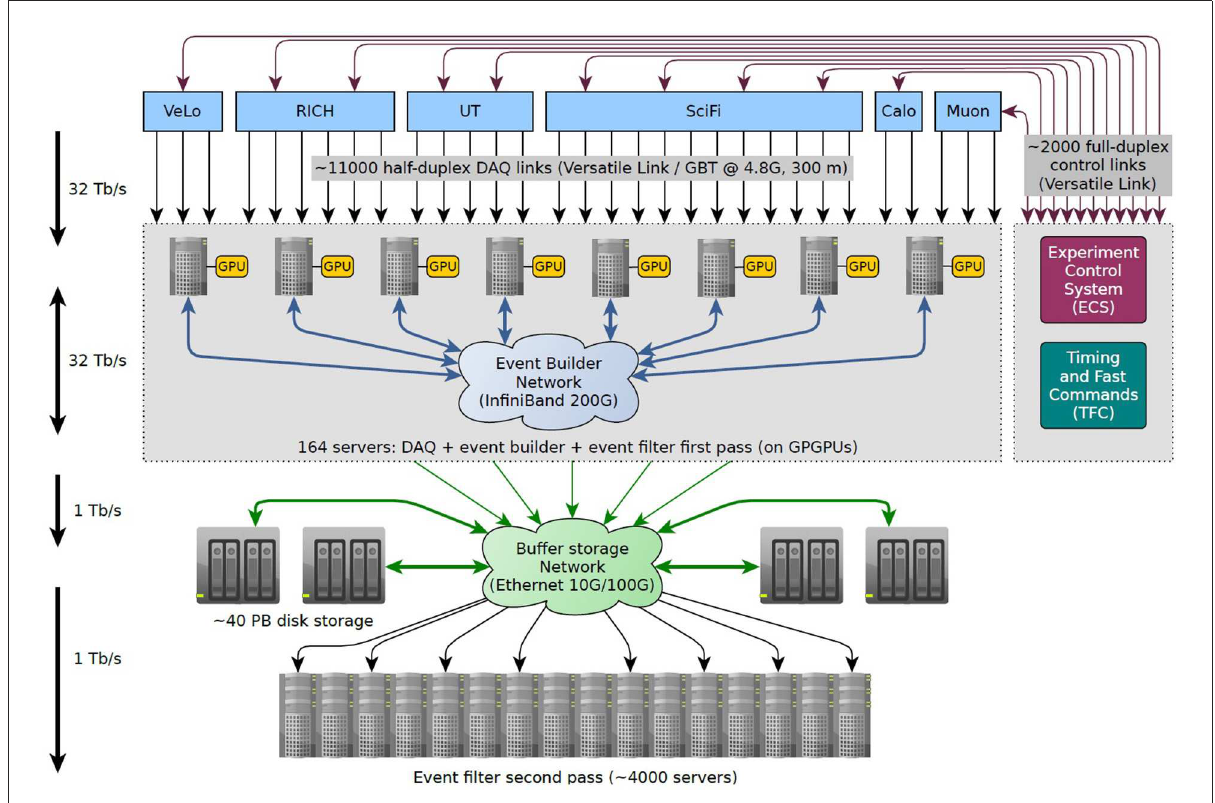
FIGURE2 The architecture of the new LHCb data readout and event-buider